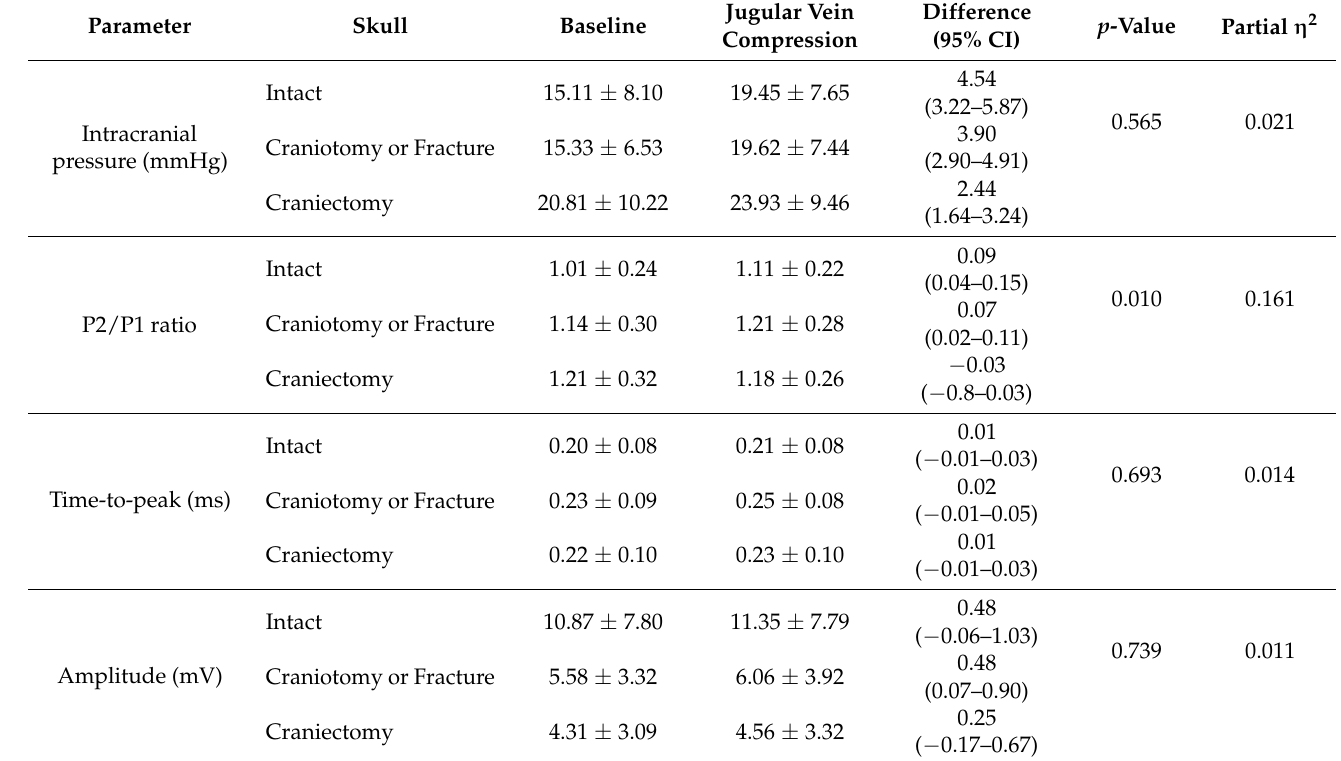
Table 2. Intracranial monitoring parameters according to skull defect ( n =